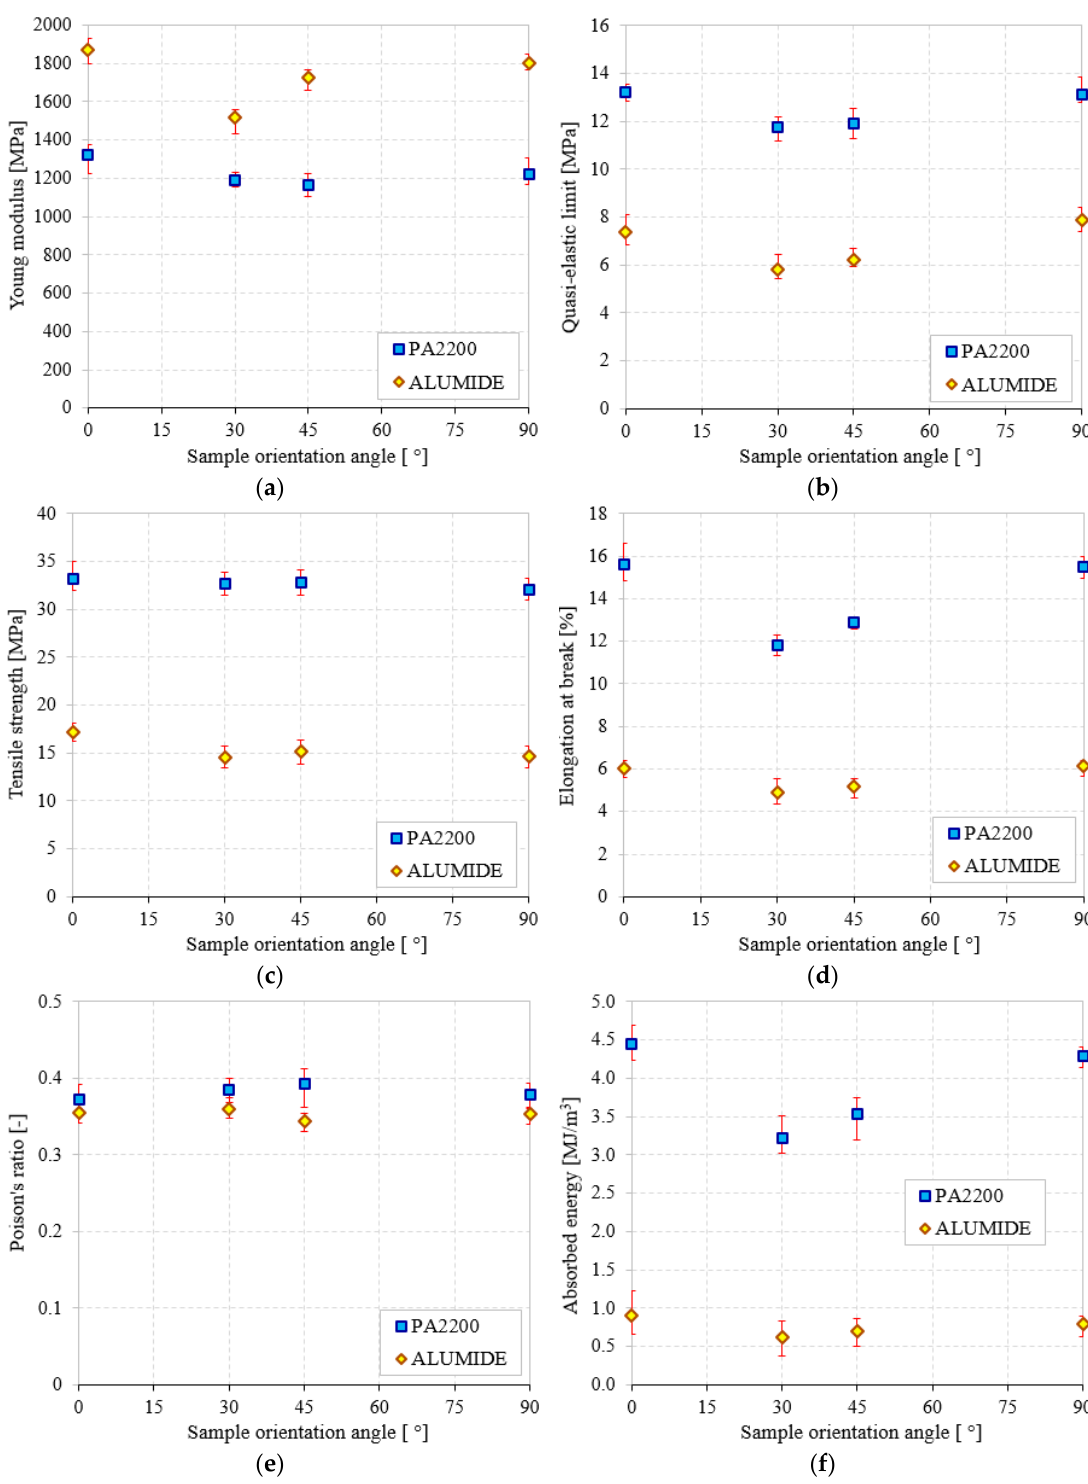
Figure 9. The main tensile mechanical properties of 3D printed PMs (PA2200 and Alumide) according to sample orientation angle (0°, 30°, 45°, and 90°): ( a ) Young modulus; ( b ) quasi-elastic limit; ( c ) tensile strength; ( d ) elongation at break; ( e ) Poisson’s ratio; ( f ) absorbed energy.